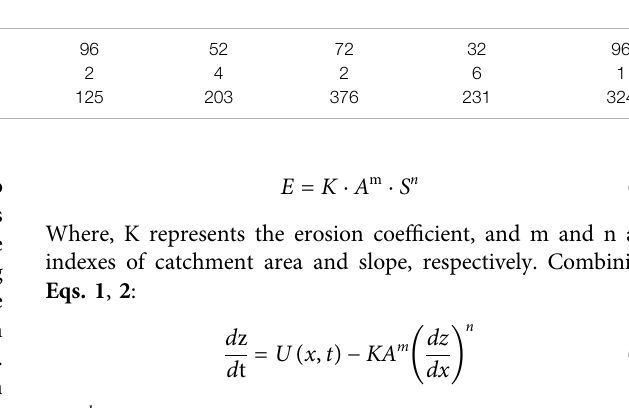
TABLE 4 | Tolerance values and knickpoint extraction results for the main stream of major sub-basins in the Indus River basin (see Figure 8 for locations). River Indus Shyok Shigar name